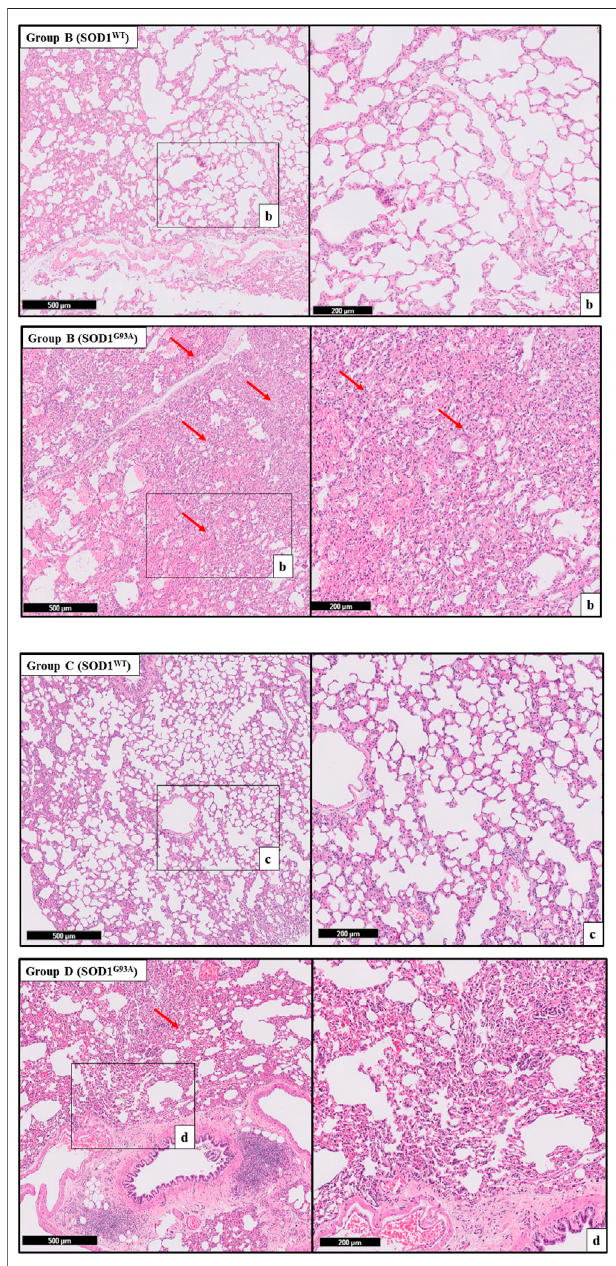
FIGURE 4 | H&E-stained sections of the lung tissue samples belonging totheSOD1 WT andSOD1 G93A ratsofgroupsBandC.Representativeimages were taken from each group. Scale lines on the left row indicate 500 μ m and thesecondrow200 μ m.Redarrows indicate theareawithatelectasisof SOD1 G93A